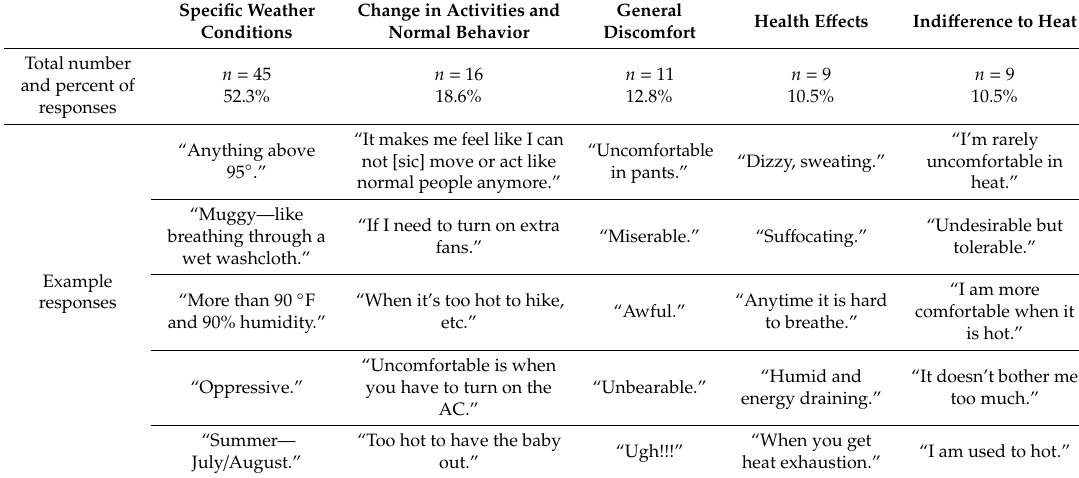
Examples of open-ended responses to the survey question, “How do you describe uncomfortably hot weather?” ( n = 86). As some responses fit into multiple themes, the total number and percentage of responses described below is greater than 86 samples and 100%. General